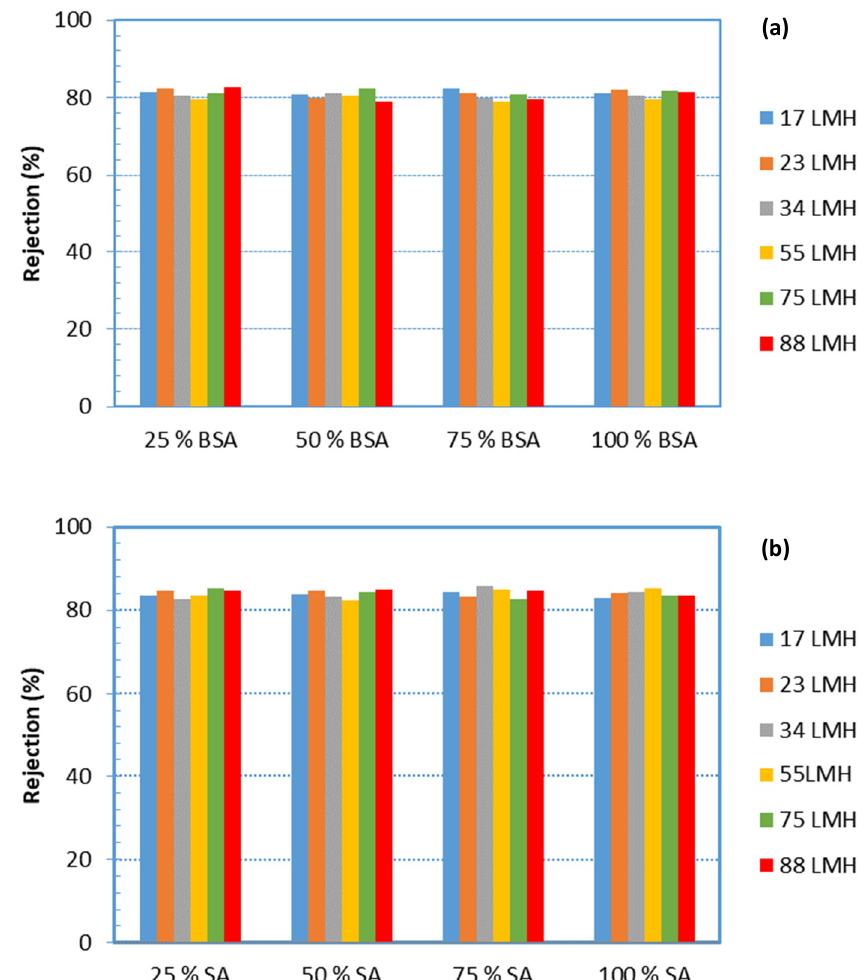
Figure 9. Rejection of organic matter by the UF membrane during filtration, for all cases. ( a ) Rejection of proteins; ( b ) rejection of polysaccharides.